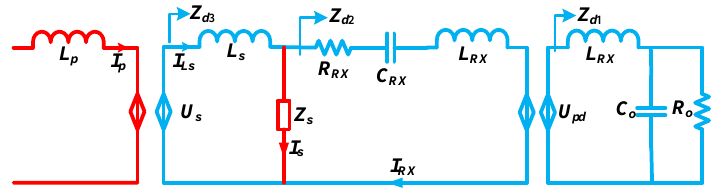
Figure 7. Equivalent circuit of data transfer channel with power flow.